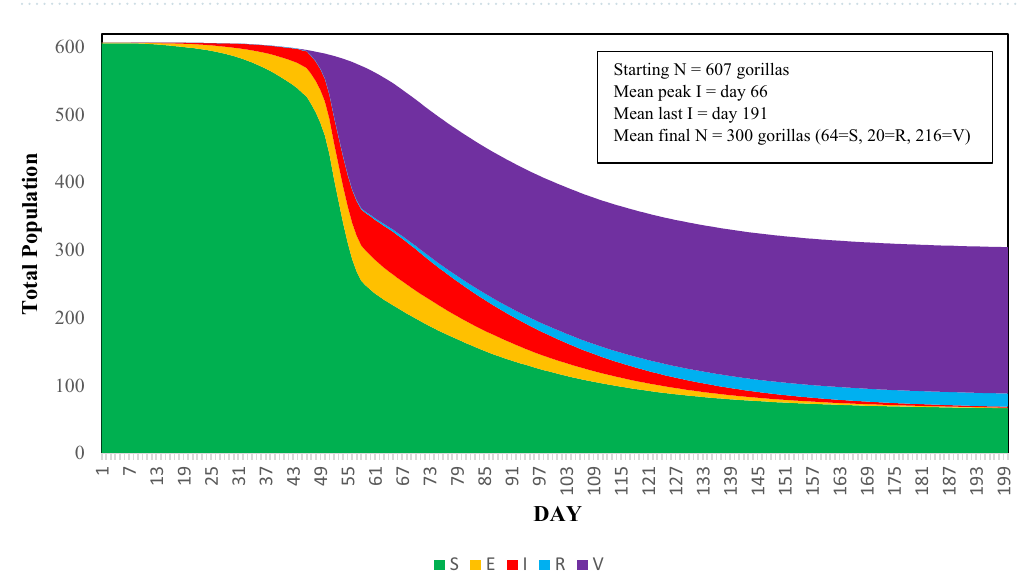
Figure 4. Proportions of SEIR states in the population and projected time course of Ebola virus transmission after entering the mountain gorilla population with one infected individual in the DRC-1 group at Day 0, when vaccinations had been administered preemptively to 50% of the habituated gorillas. S—Susceptible, never infected; E—Exposed and infected; I—Infectious; R—Recovered; V—Effectively vaccinated. Lines averaged across 500 iterations.